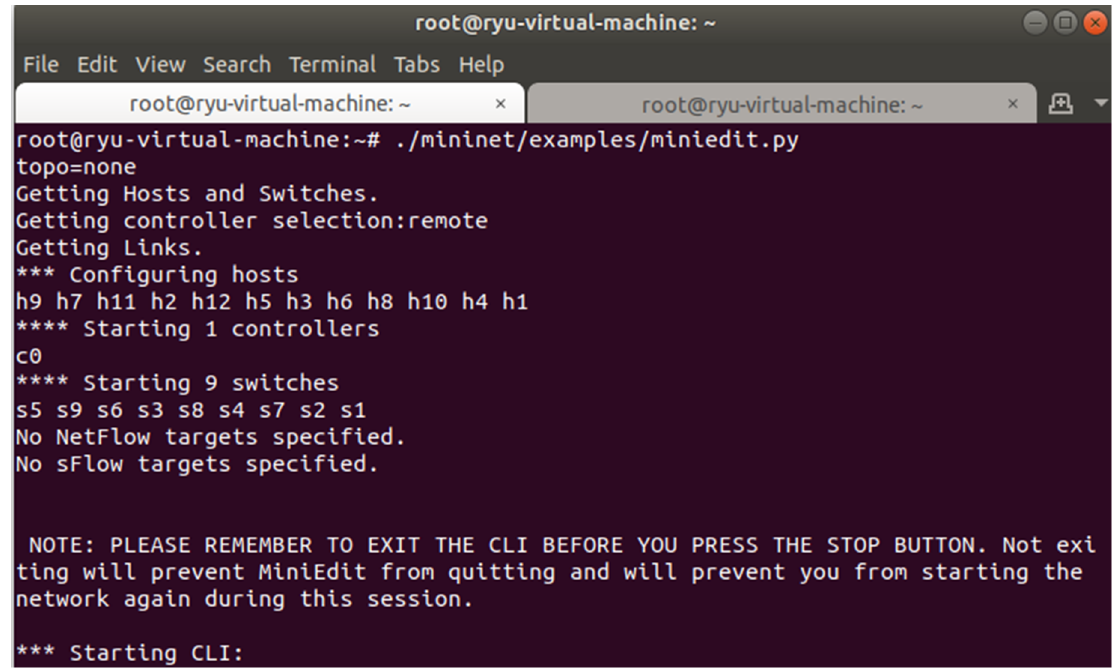
Figure 29. Tree custom network topology with Ryu controller.